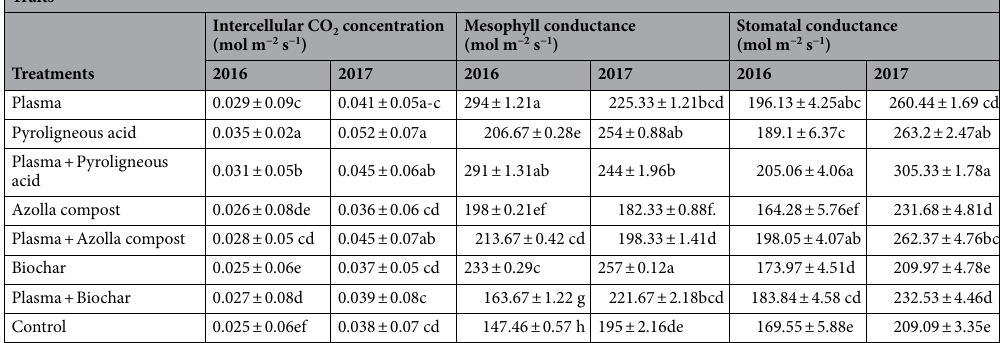
Table 4. Mean comparison of effect of application of plasma, pyroligneous acid, azolla compost and biochar on physiological responses of wheat. Means in each column followed by similar letter(s) are not significantly different at 5% probability level using LSD Rang Test.